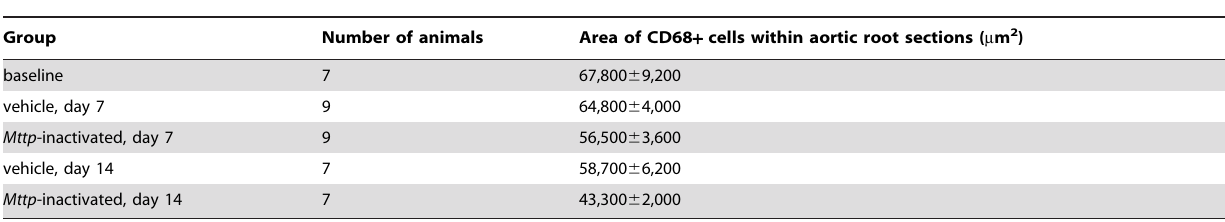
Table 2. In vivo lipid lowering leads to reduced aortic root CD68 + area, independent of diet switch.